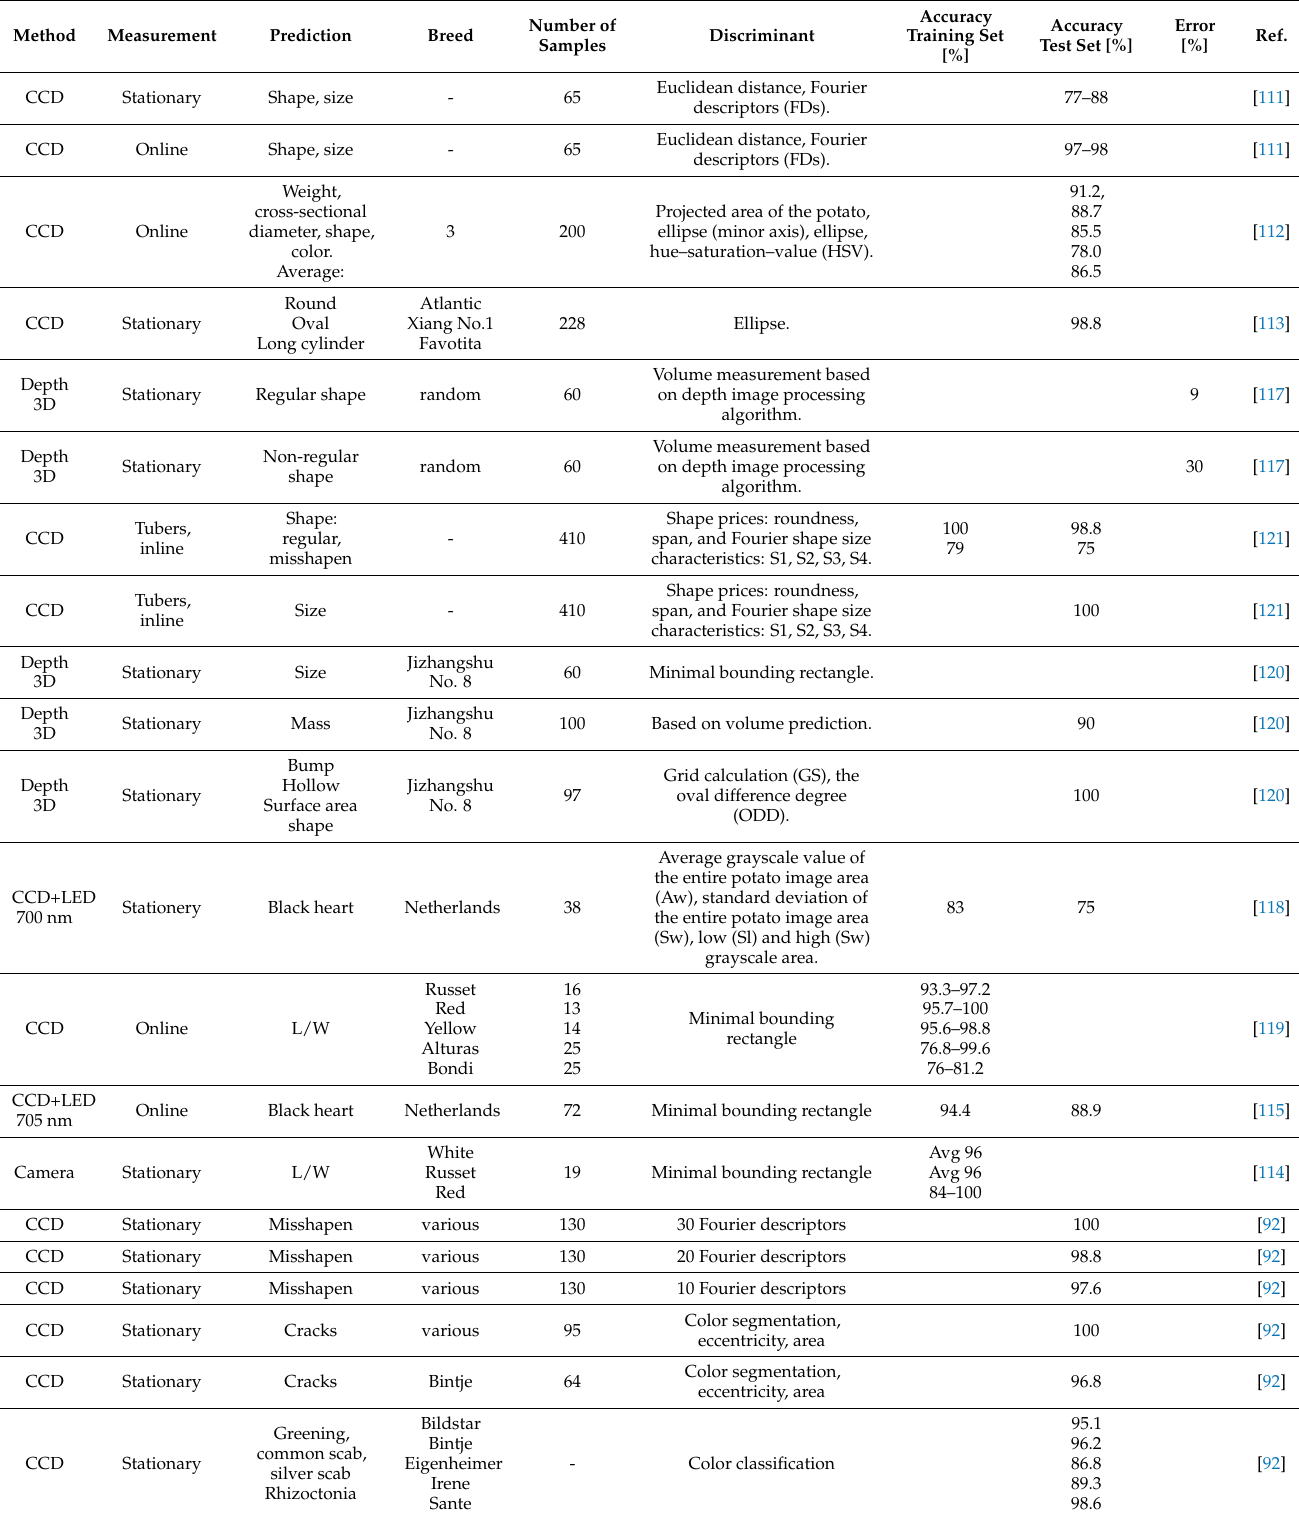
Table 4. Application of vision systems in light range methods in quality assessment of